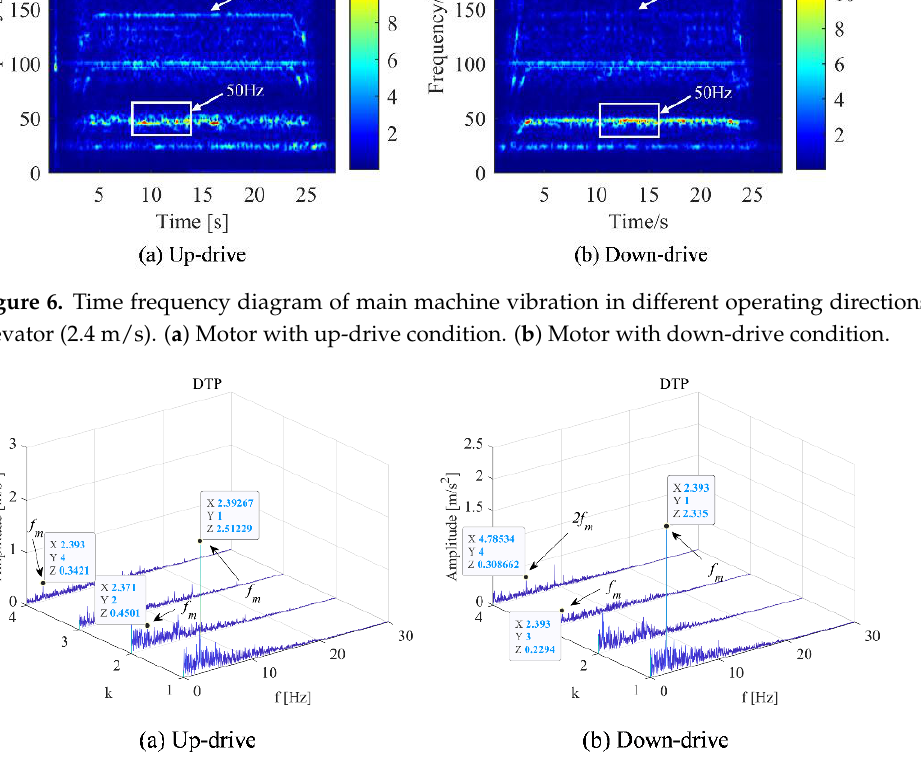
Figure 8. Vibration spectrum diagram of elevator main engine with different loads. ( a ) Motor run- ning under 140kg load condition. ( b ) Motor running under 325kg load condition.